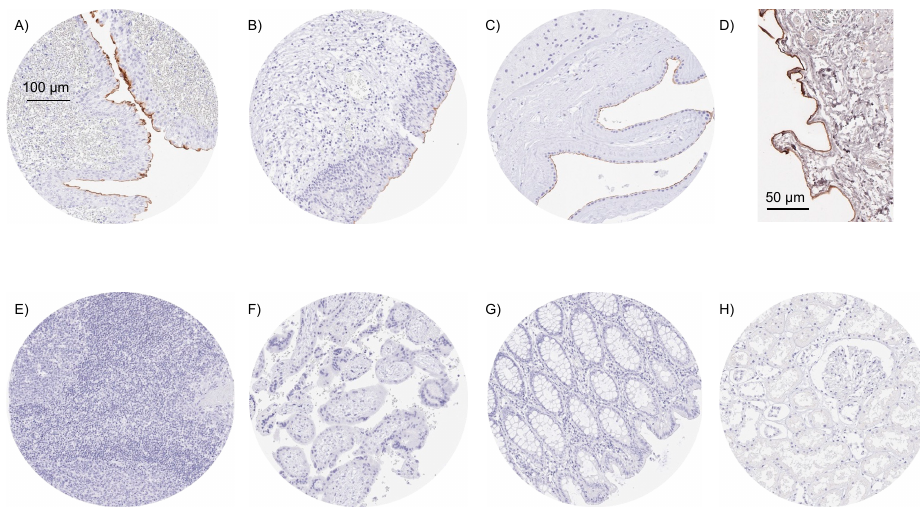
Figure 1. Examples of Upk3b immunostaining in selected normal tissues . A strong apical membranous Upk3b positivity is seen in umbrella cells of urothelium of the renal pelvis ( A ), umbrella cells of the urinary bladder urothelium ( B ), amnion cells of the placenta ( C ), and of mesothelial cells of the peritoneum ( D ). Upk3b staining is absent in tissues from tonsil ( E ), first trimenon placenta ( F ), colon mucosa ( G ), and the renal parenchyma ( H ).